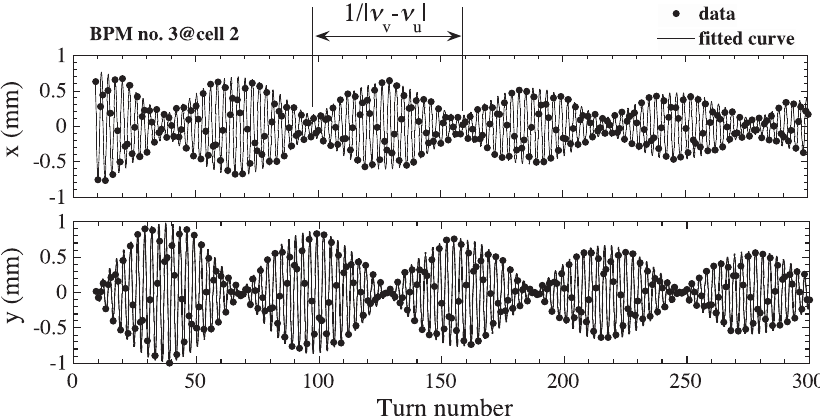
FIG. 1. An example of the turn-by-turn BPM data (dots) measured at the working point ð (cid:1) x ; (cid:1) y Þ ¼ ð 40 : 3509 ; 18 : 3477 Þ near the linear difference resonance. The solid lines show the curves of Eqs. (5) and (6) fitted to the